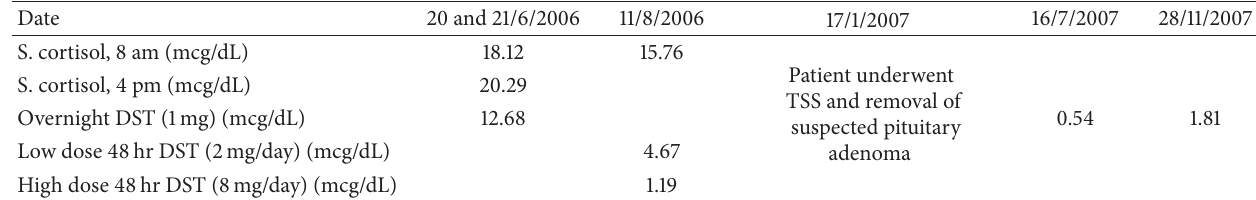
Table 1: Investigation summary prior to the first surgery.